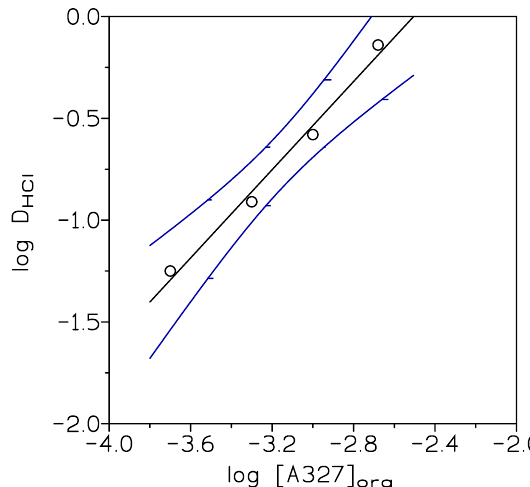
Figure 1. Variation of log D HCl with log [A327] org . Aqueous phases: 1 M HCl. Organic phase: 0.05 – 0.4 M amine A327 in toluene. Temperature: 20 °C. Time: 10 min. V org /V aq : 1. Dotted line shows 95% confidence interval of the regression line.